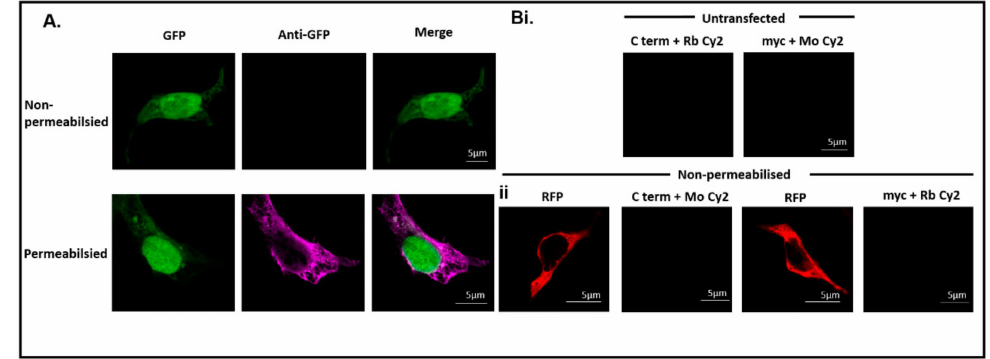
Figure 2. Antibodies do not penetrate non-permeabilised cells. ( A ) Green fluorescent protein (GFP) (green) is visualised in transfected HEK 293T cells. In the non-permeabilised cells fluorescence cannot be detected using an anti-GFP antibody. Fluorescence, from the anti-GFP antibody (magenta), is only detected in permeabilised cells, demonstrating that antibodies do not penetrate non-permeabilised cells. Scale bar, 5 µ m. ( B ) (i) Untransfected cells stained with the C-terminus and myc antibodies. No fluorescent signal is detected confirming that there is no non-specific background from the secondary antibodies. (ii) Transfected cells (red) stained with the C-terminus and myc antibodies. The secondary antibodies have been switched, and the lack of fluorescent staining confirmed there was no non-specific binding of the secondary antibodies in non-permeabilised cells. Scale bar, 5 µ